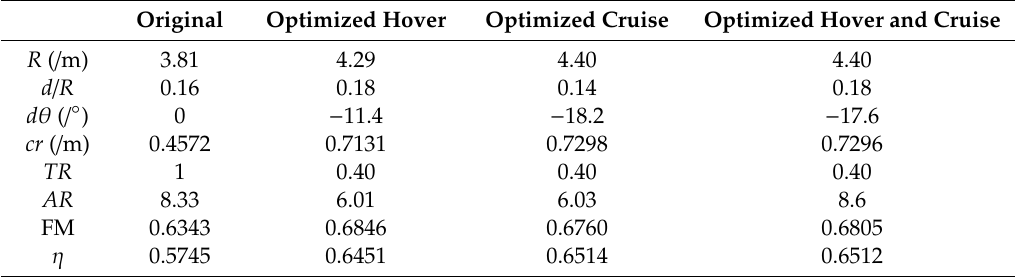
Figure 10. Optimization samples in hovering and cruising state based on ASA (N is the population size). Table 4. Parameters of original and single/multi-objective optimized rotors.